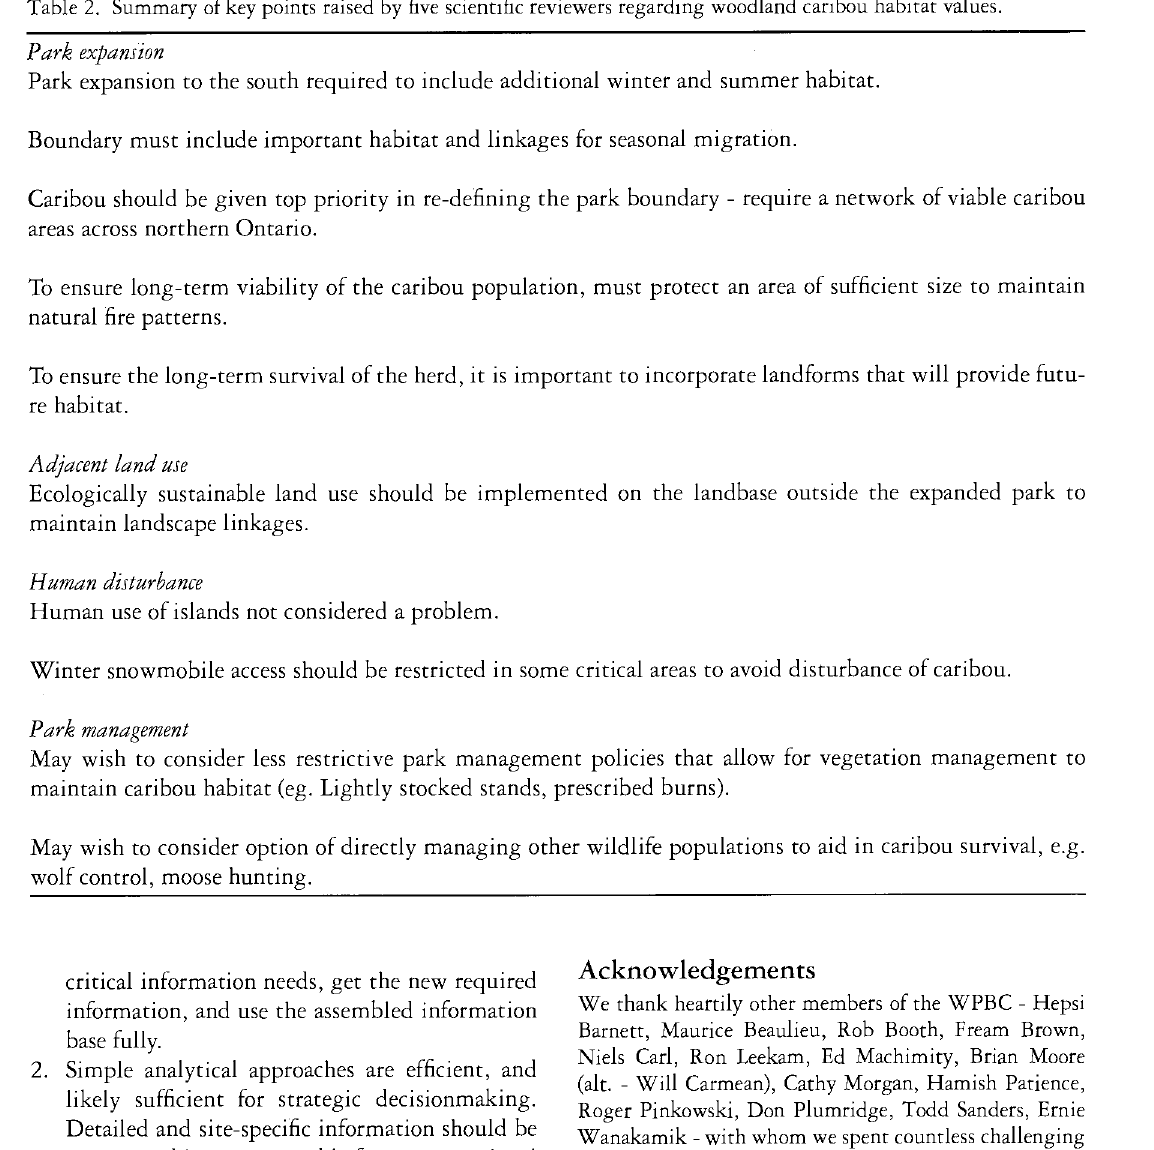
Table 2. Summary of key points raised by five scientific reviewers regarding woodland caribou habitat values. Park expansion Park expansion to the south required to include additional winter and summer habitat. Boundary must include important habitat and linkages for seasonal